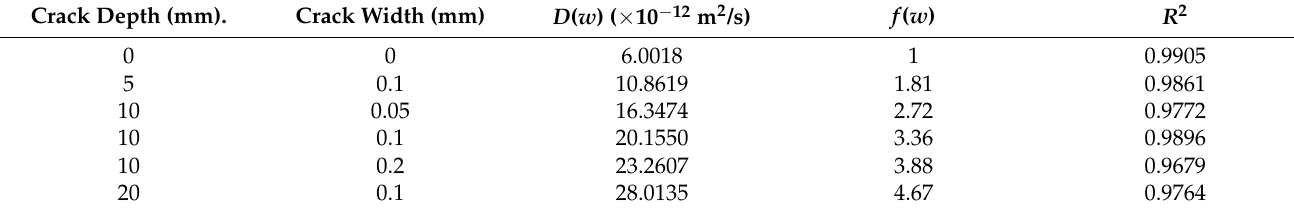
Table 4. Equivalent chloride diffusion coefficients of cracked specimens. Crack Depth